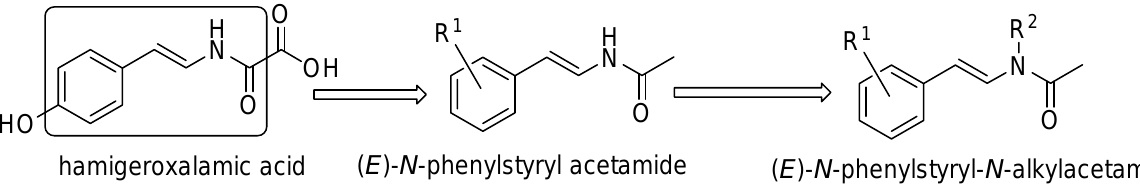
Scheme 1. Structure of hamigeroxalamic acid, ( E )- N -phenylstyryl acetamide and ( E )- N- phenylstyryl -N- alkylacetamide.